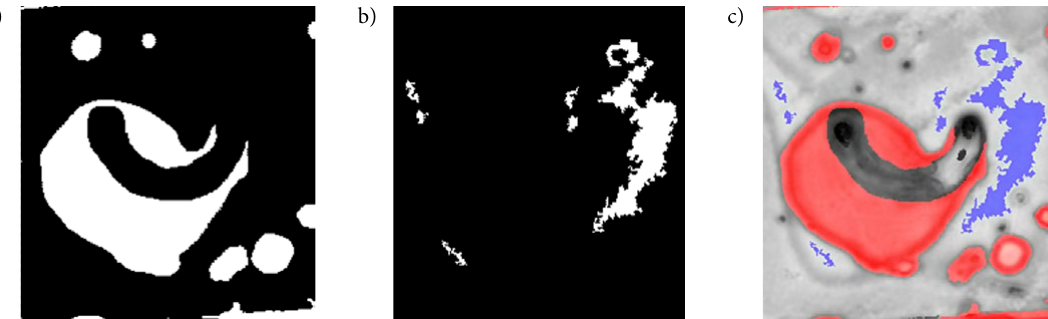
Fig. 7. Inner layer image analysis results for dark area (a), bright area (b) and the two combined (c)